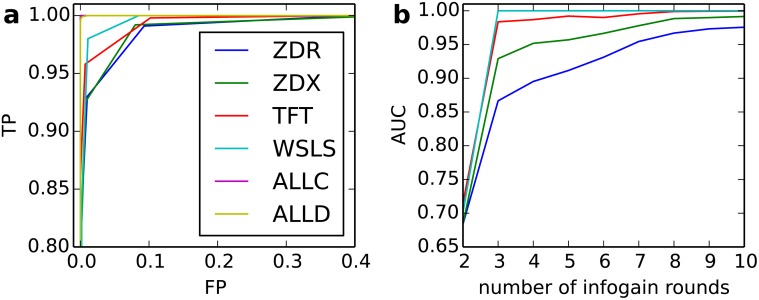
Accuracy of information gain phase.A: ROC for ε = 0.05 and 10 infogain rounds. Vertical axis: true positives, Horizontal axis: false positives. ZDR is the hardest strategy to recognize among those tested. B: AUC for IP against ZDR for ε = 0, 0.01, 0.05, 0.1.